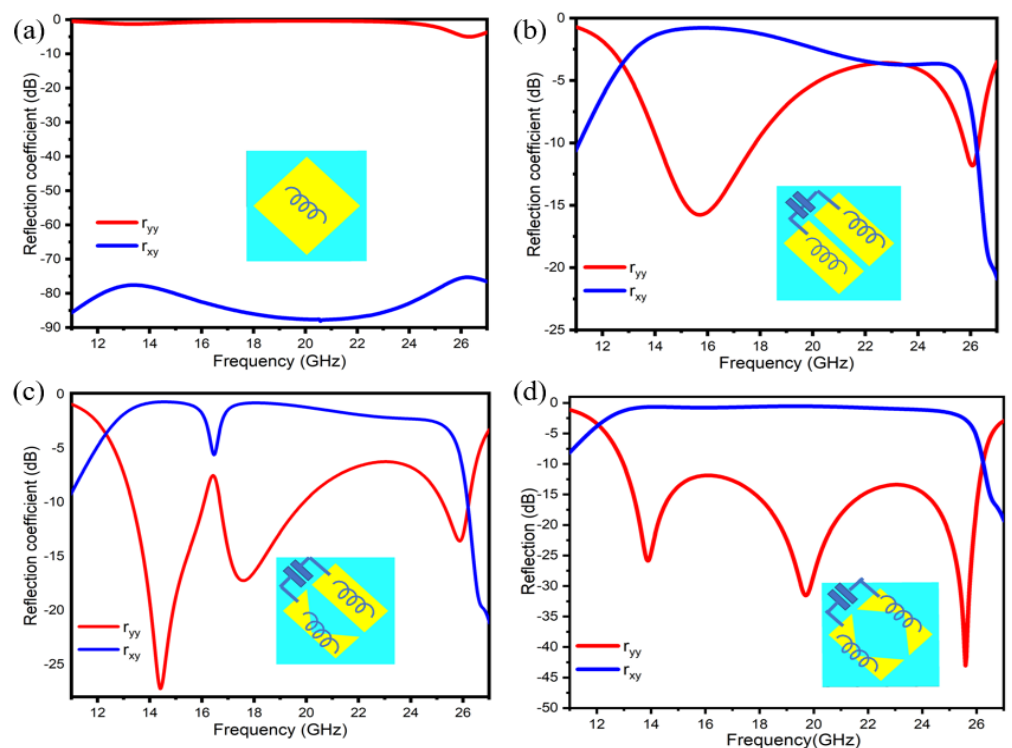
Figure 2. Design process along with respective reflection characteristics of the proposed anisotropic reflective metasurface with ( a ) a 45 ∘ rotated square patch, ( b ) a rectangular split width of 0.4 mm is employed at 45 ∘ rotation with respect to xy − axes, ( c ) a triangular part is cut off from the lower portion, and ( d ) a rhombus − like shape is removed from 45 ∘ rotated square patch.